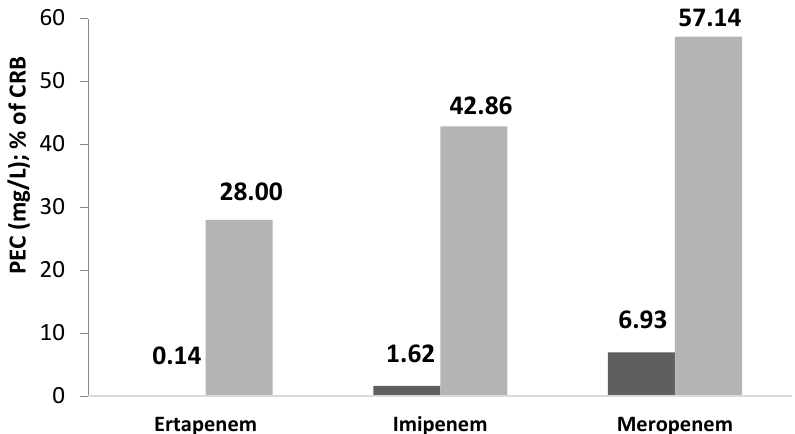
Figure 3. Graphical representation of the Predicted Environmental Concentration (PEC) ( ■ ) (in mg/L): in comparison with the percentage of Carbapenem-resistant bacteria CRB) ( ■ ) (in %) in MCH.